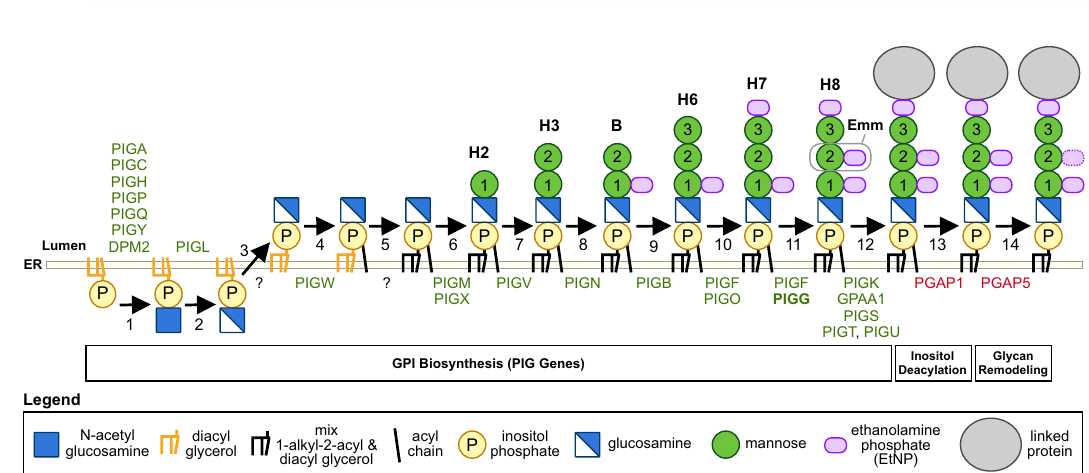
Figure 5. GPI anchor synthesis pathway. The schematic shows the relevant part of the GPI anchor synthesis pathway. The proteins involved in each step are indicated below the line. PIGG transferase (bold) is reported to be expressed during erythropoiesis, but loss of function in Emm− individuals would mean EtNP is not added to mannose 2. EtNP on mannose 2 is the likely antigenic target responsible for